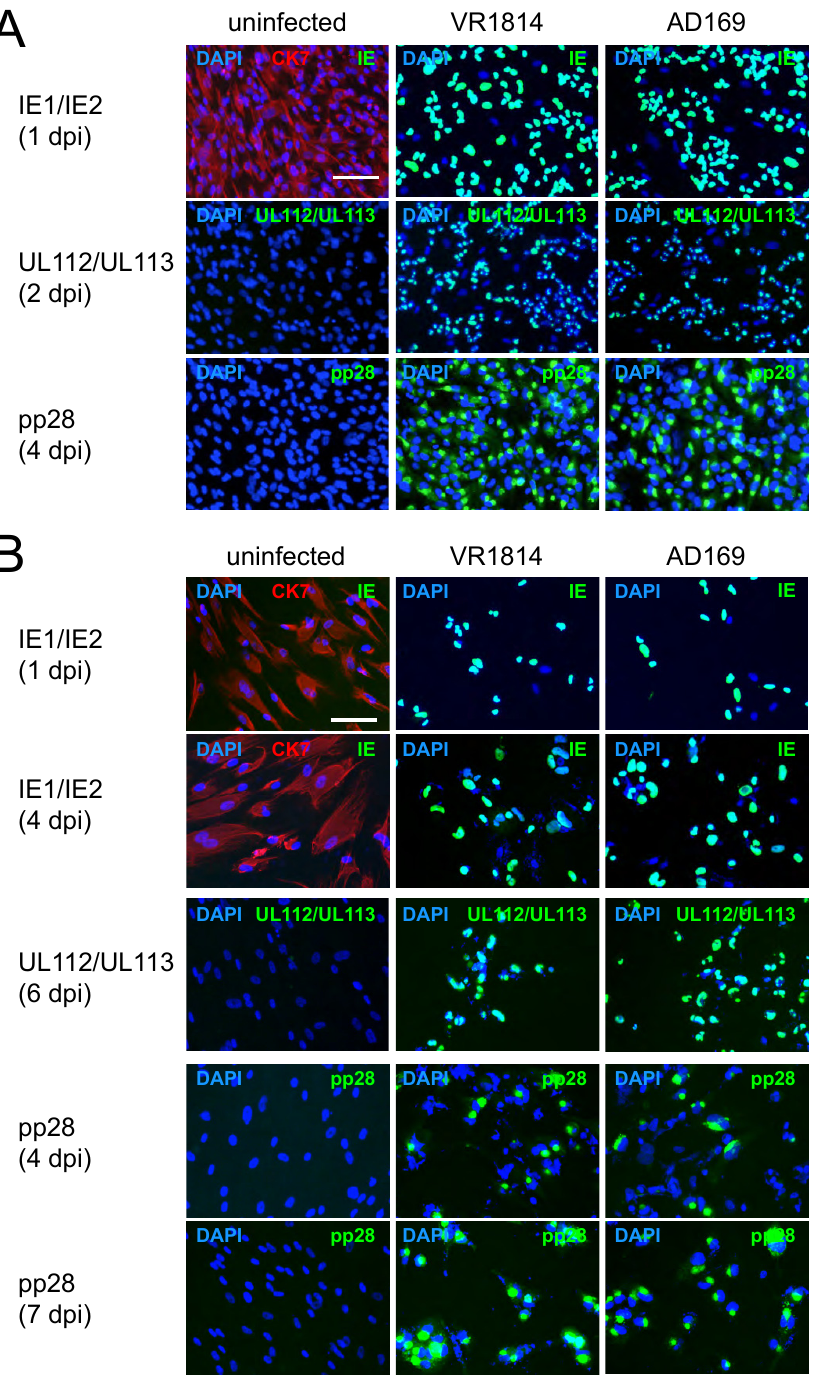
pUL112/pUL113 or pp28 at the indicated time points (green). Mock-infected controls were immunostained for CK7 (red). Nuclei were counterstained with DAPI